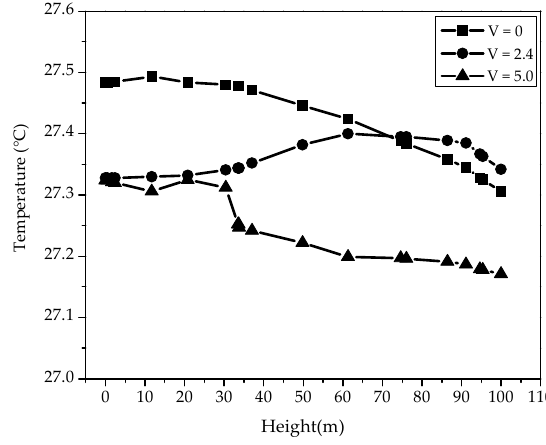
Figure 9. Vertical temperature inside the street canyon ( V is the velocity of prevailing wind, m ∙ s (cid:2879)(cid:2869) ).